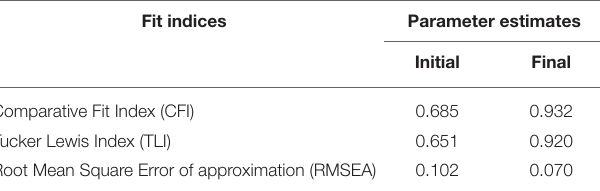
TABLE 6 | Goodness of fit measures of CFA